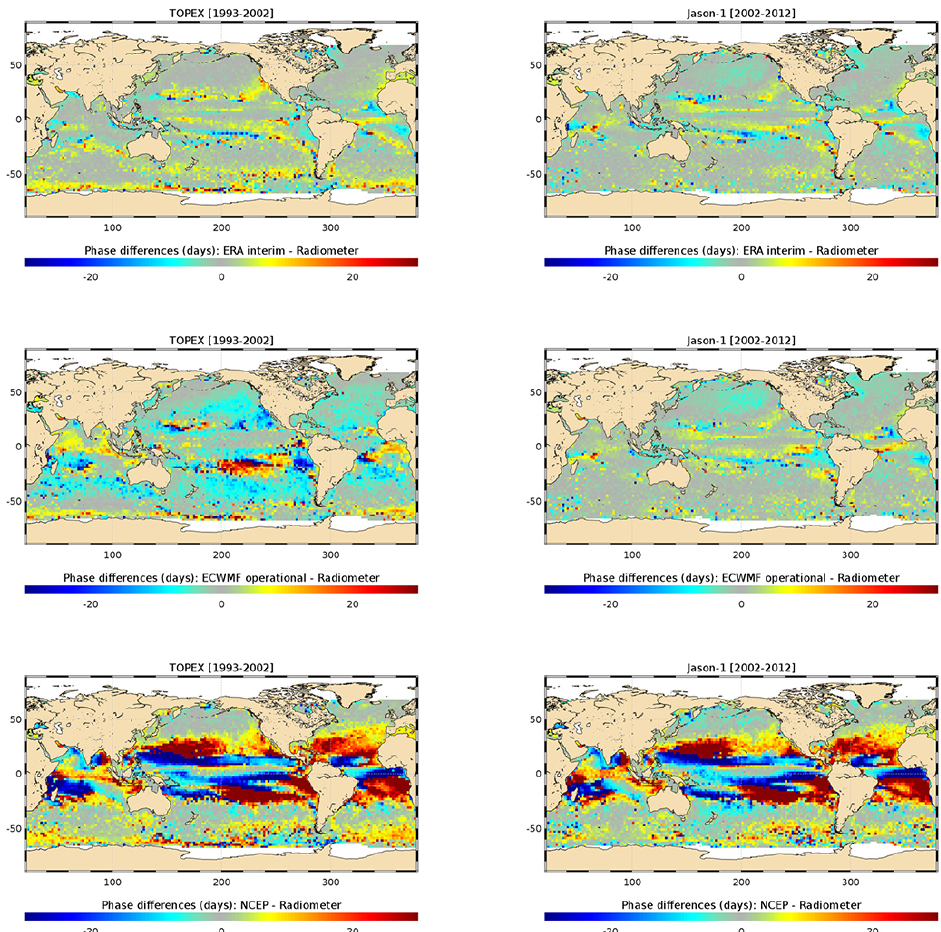
Figure 8. Regional differences in the annual signal’s phase of the wet troposphere corrections (in days) comparing each model (top: ERA- Interim; middle: operational ECMWF; bottom: NCEP/NCAR) with the radiometers over the first (left, TP data) and the second (right, Jason-1 data) altimetry decade. As in Fig. 8, we compare here the annual signal of the WTC